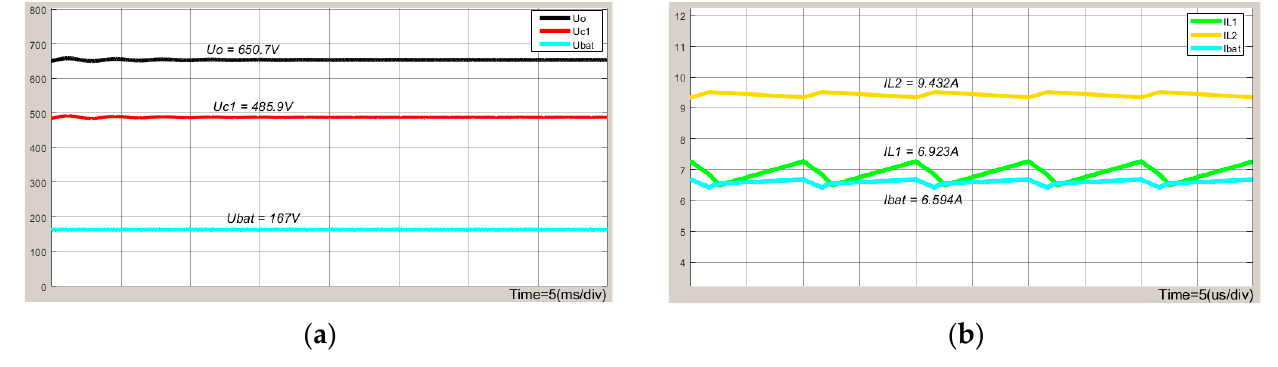
Figure 10. The simulation results of charging work: ( a ) the load and battery output voltage in state